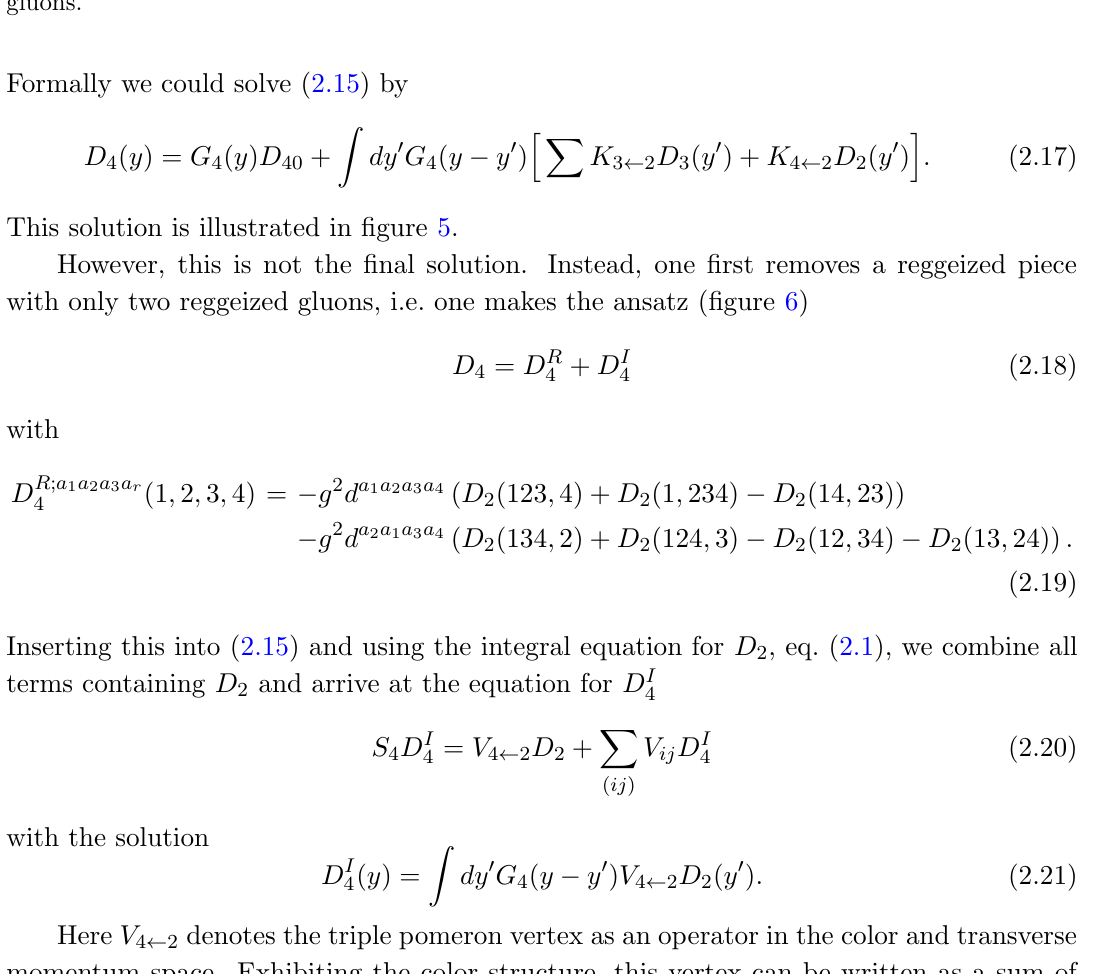
Figure 5 . Amplitude with 4 reggeized gluons. G 4 denotes the Green’s function for 4 reggeized